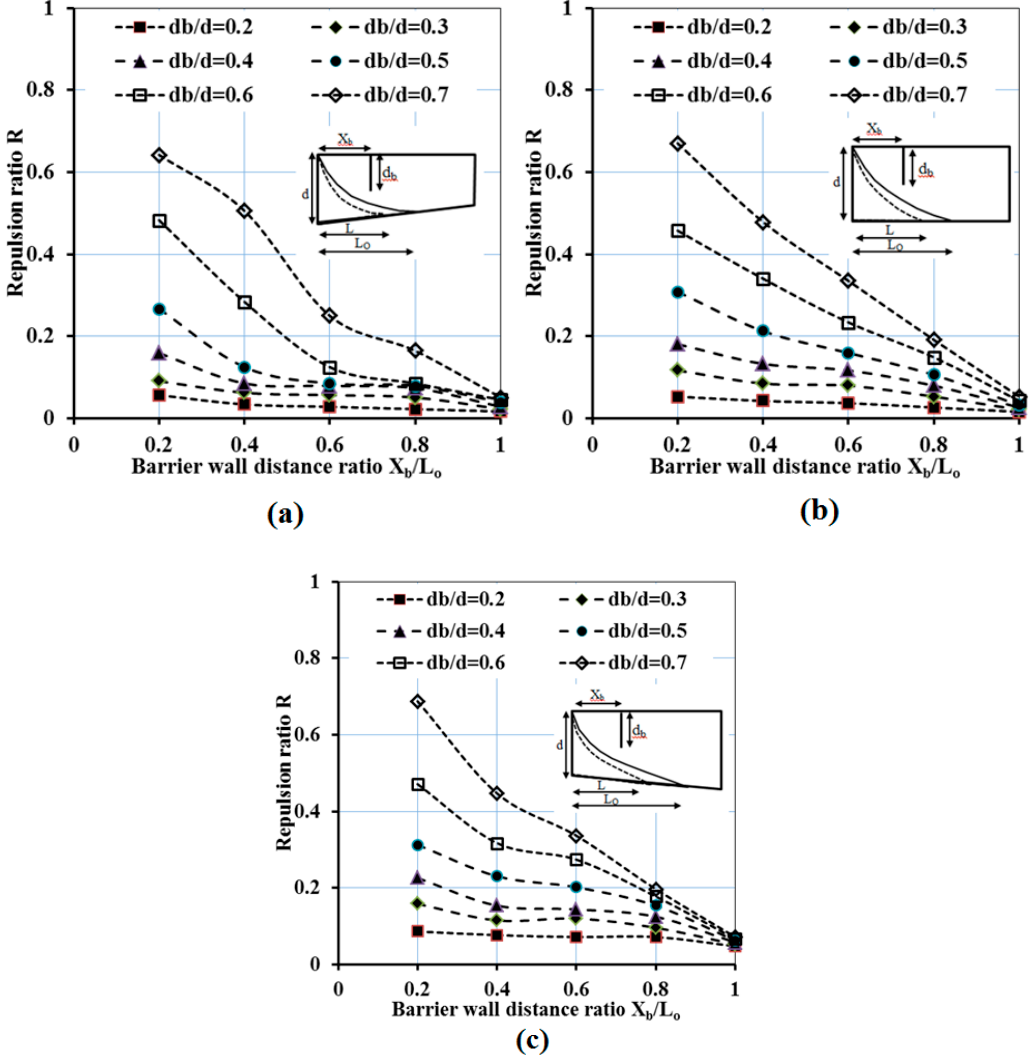
Figure 6. Relationship between the barrier wall distance ratio and R for different bed slopes tan β : ( a ) 0.02, ( b ) 0.0, and ( c ) − 0.02. ( a ) 0.02, ( b ) 0.0, and ( c ) −